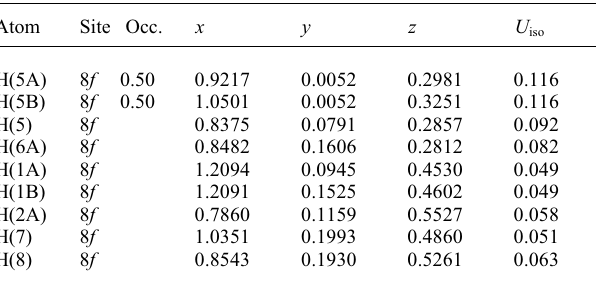
Table 2. Atomic coordinates and displacement parameters (in Å 2 )